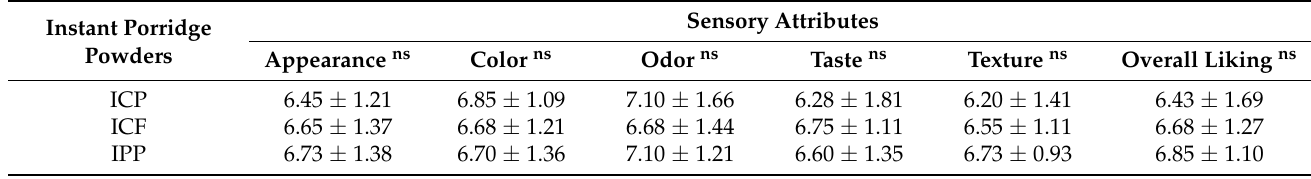
Table 3. Sensory evaluation of instant porridge powders.